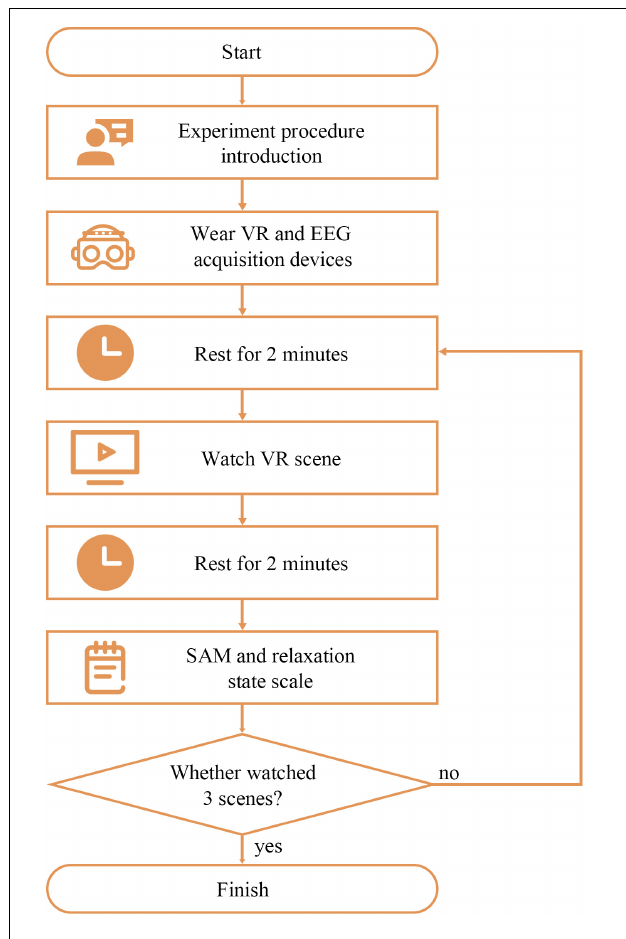
FIGURE 3 | Experimental